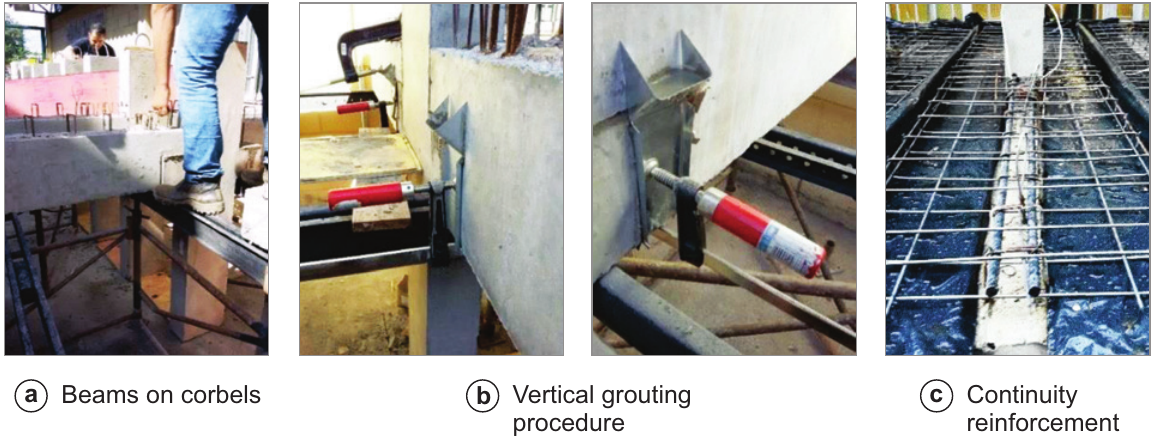
Figure 13 Setting beams on corbels, vertical grouting (PC and LC) and continuity reinforcement crossing the column (PC)